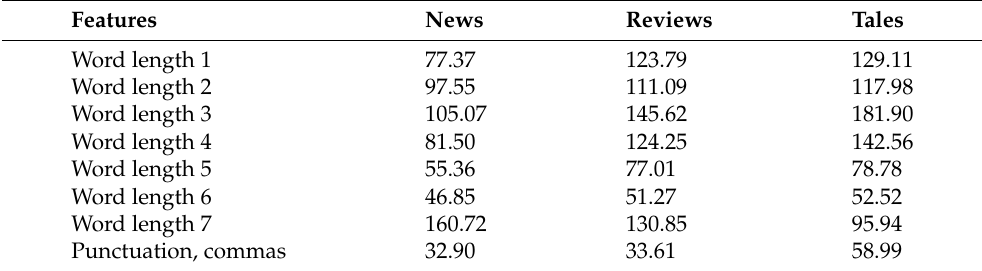
Table 2. Average shallow features per